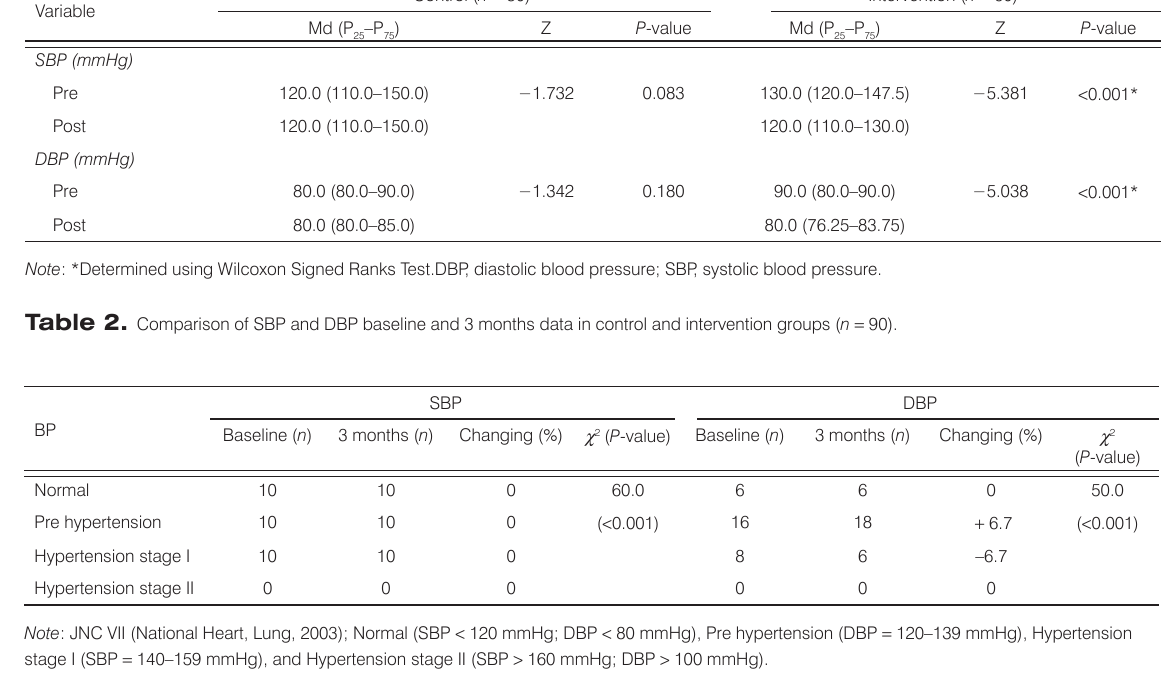
Table 3. The comparison of number of type BP baseline and 3 months data in the control group ( n = 30).